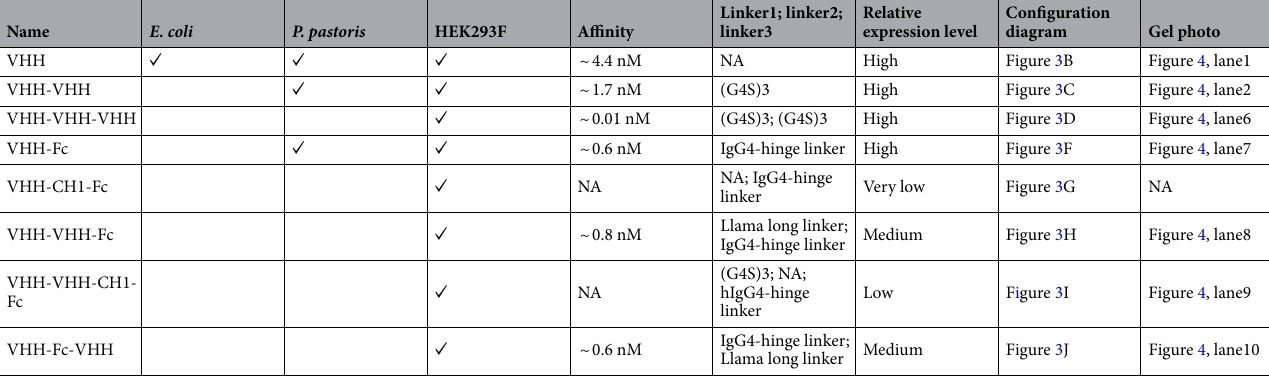
Table 1. Intercomparison of multiple VHH-B11-derived conformations. Note: “VHH” represents single domain Ab VHH-B11. “ ✓ ” indicates that the Ab is expressed in this expression system. “-” represents the linker between the domains (VHH, CH1 or Fc). “(G4S)3” is a 15-peptide linker (amino acid sequence: GGGGSGGGGSGGGGS). “IgG4-hinge linker” indicates the hinge region between human Fab and human IgG4 Fc (amino acid sequence: PPCPSCPAPEFLGGPS); “Llama long linker” represents the hinge region between llama Fab and llama IgG2 Fc (amino acid